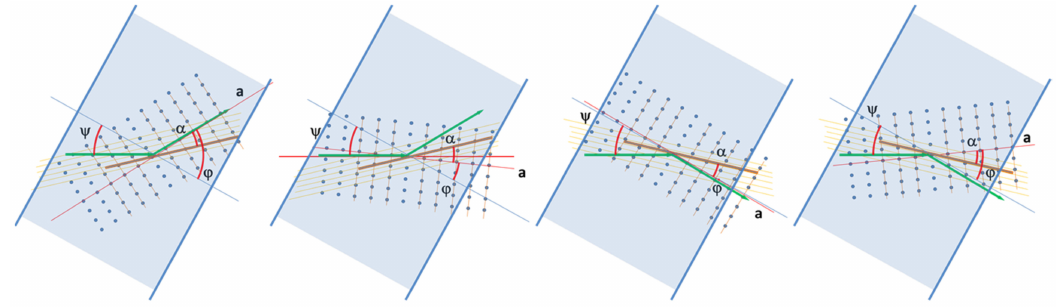
Figure 5. Different possible alignments of the crystalline lattice within the sample for the reflection (1 2 0).